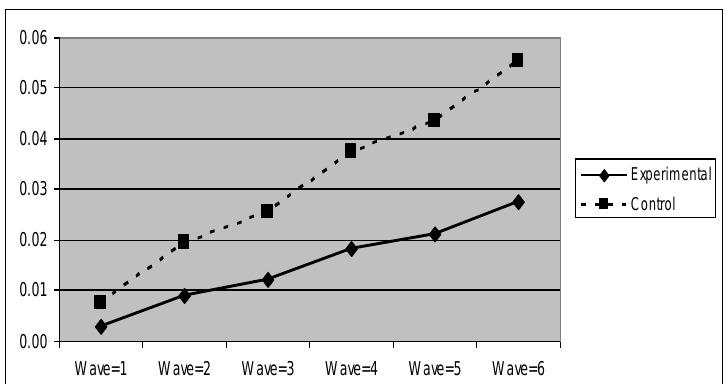
FIGURE 4 . Growth trajectories of the experimental group (participants who joined the Tier 1 Program only) and control group using the item score of heroin use as the outcome indicator.